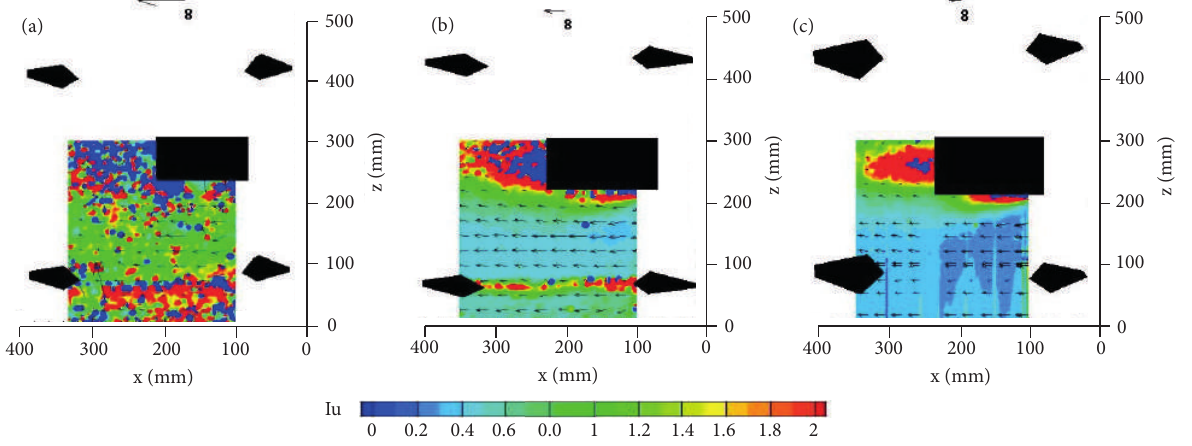
Figure 26. Turbulence Intensity and velocity vectors for α = 0°, β = 90°, Re = 1.7 × 10 5 and varying the height of laser